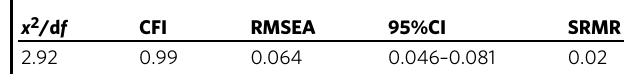
Table 4 Model fi t indices for the con fi rmatory factor analyses (CFAs).